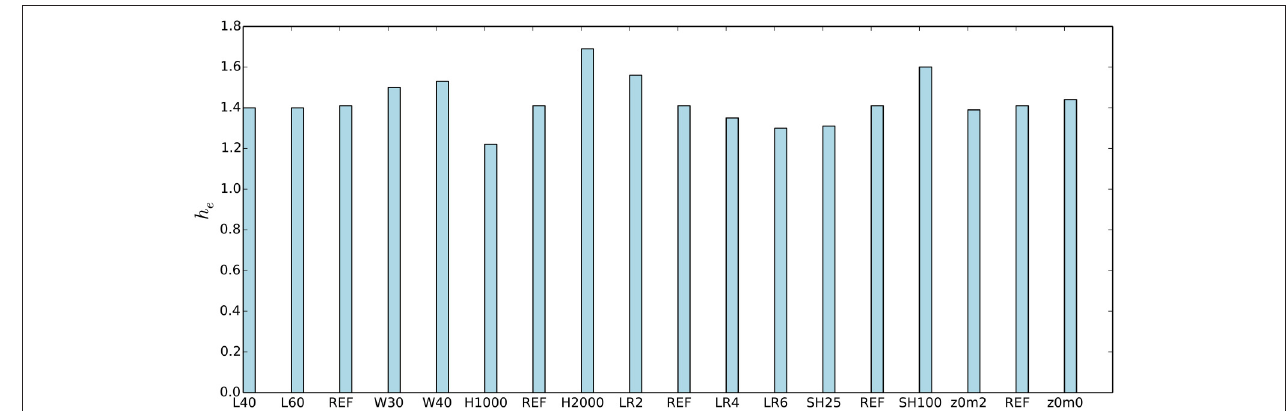
FIGURE 7 | Diagnosed depth of the inflow layer, h e